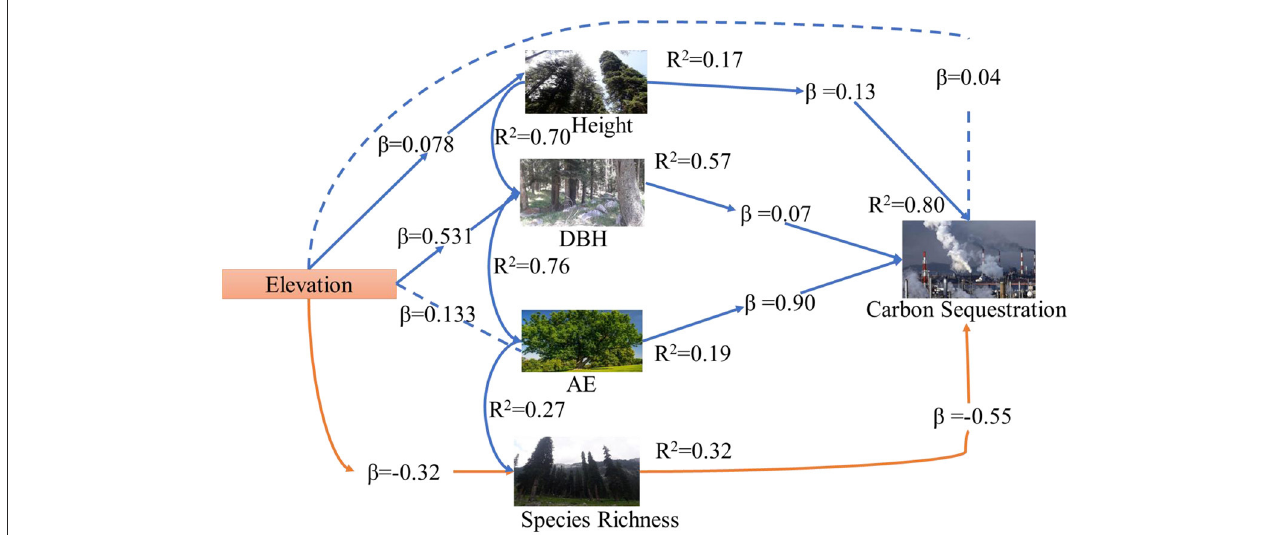
FIGURE3 SEM linked elevation, CS, CA, DBH, H, and SR in Pakistan’s different forests.